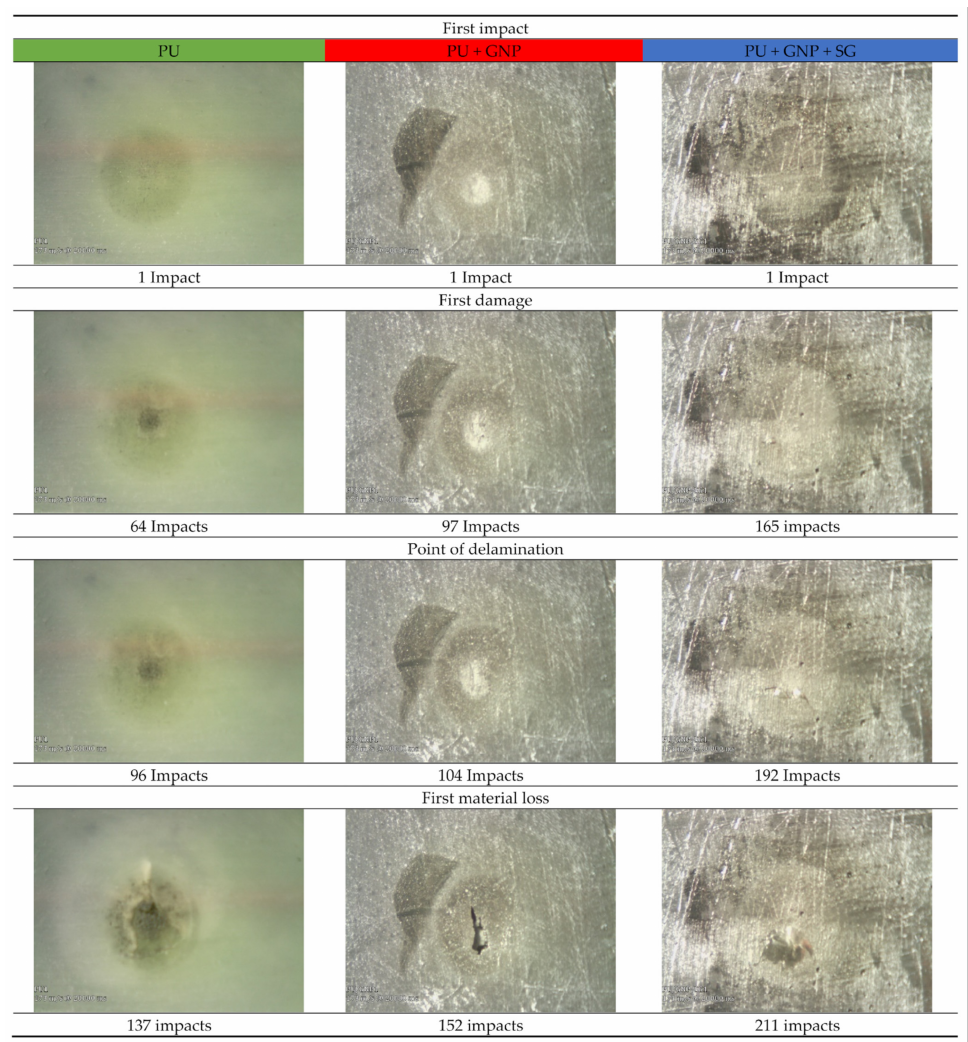
Figure 7. The extent of damage to the three coatings at various stages of the ball impact testing, from the 3 different coatings PU, PU + GNP, and PU + GNP + SG. Images are extracted stills during testing, from the DinoLite